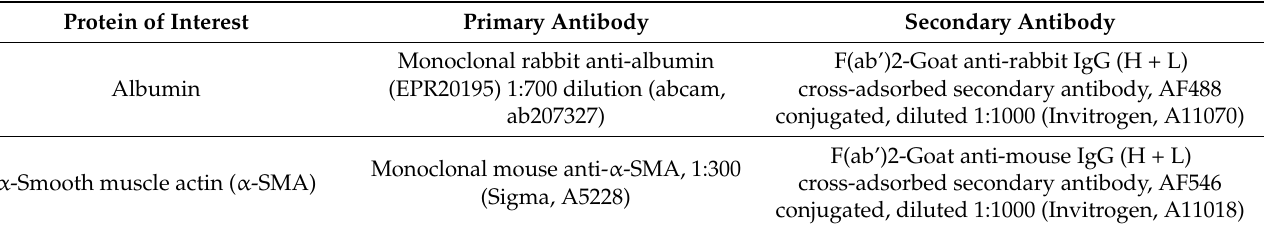
Table 1. Antibodies used for immunostaining.